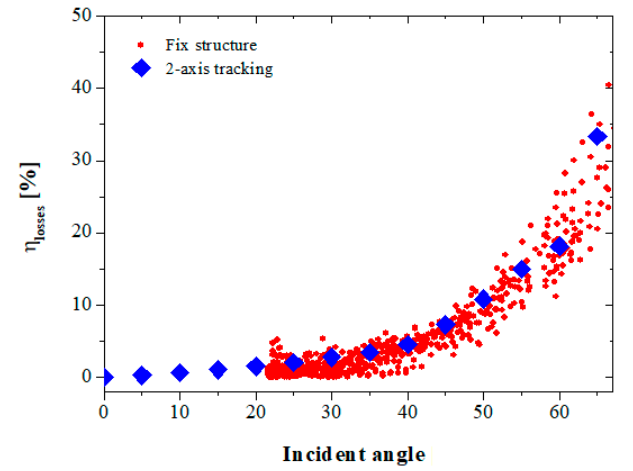
Figure 7. Losses derived from the 1DPC and solar cell optical coupling measured into a 2-axis tracking system, to avoid the effect of irradiance spectrum modification during the day. Red circles represent data collected at the fixed structure (Section 3.1), while blue diamonds correspond to data collected from the 2-axis tracking experiment (Section 3.2).